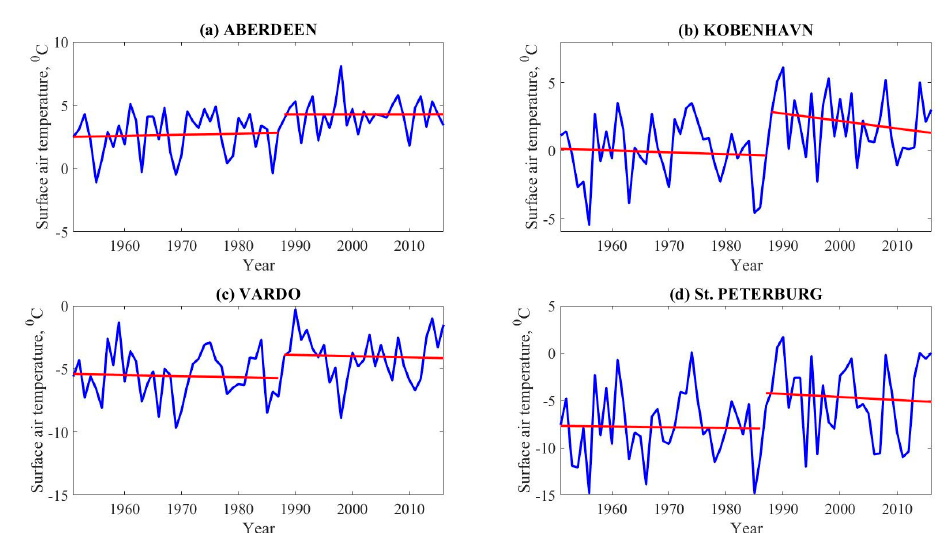
Figure 4. The model of stepwise changes for the SAT in February at the weather stations, ( a ) Aberdeen, ( b ) Kobenhavn, ( c ) Vardo and ( d ) St. Peterburg.